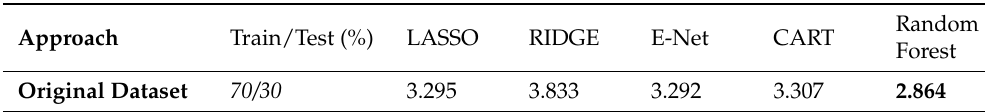
Table 2. Model performances, as MAE, in the regression task for the original dataset under the 70/30% training/test set split.